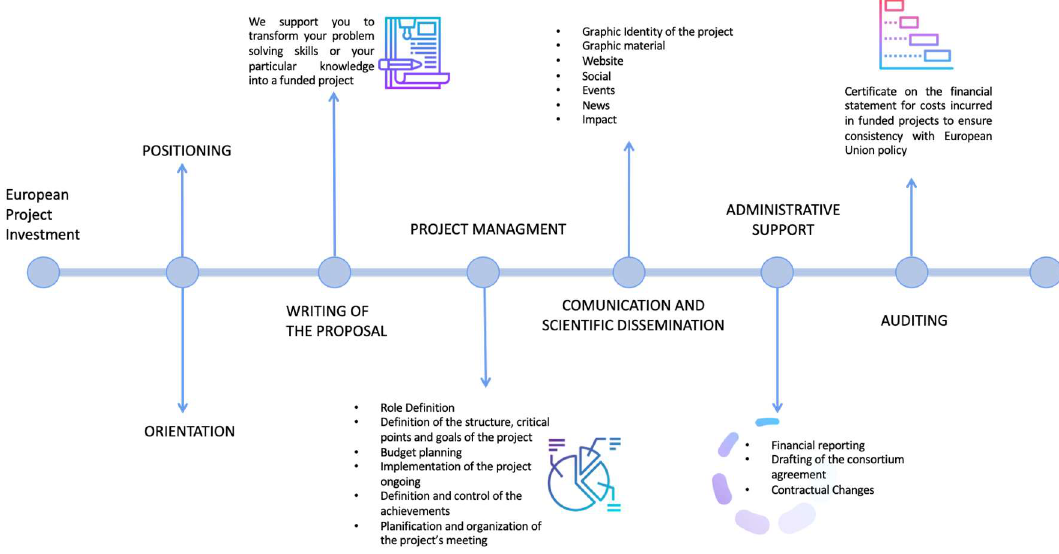
Figure 1. Main stages of presentation and management of a European project within a research in- stitute.